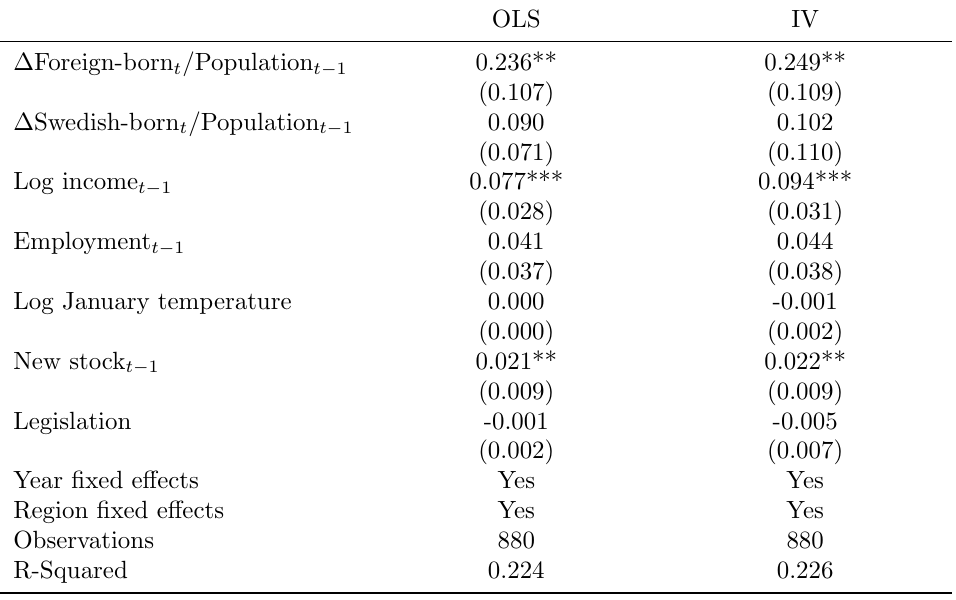
Table 1: The relationship between migration and rental